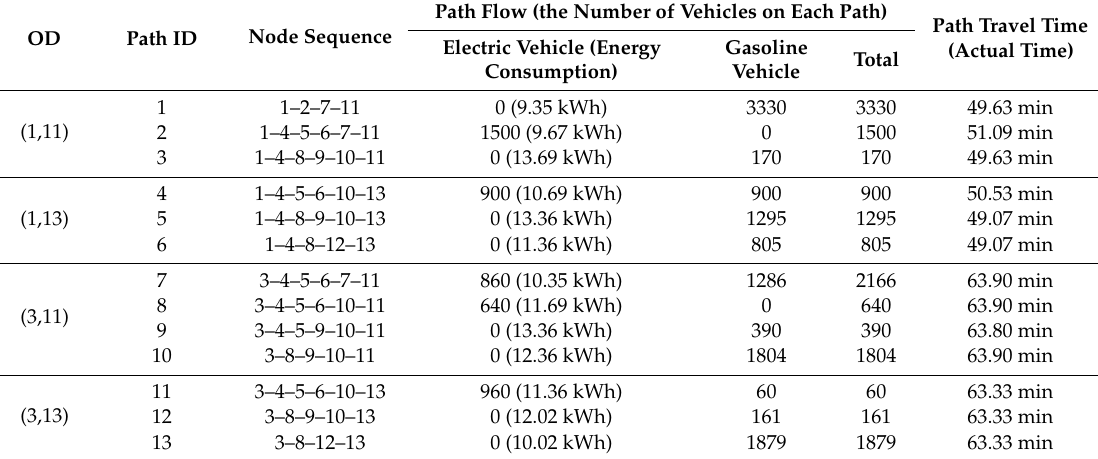
Table 4. Path flow and path travel time under the